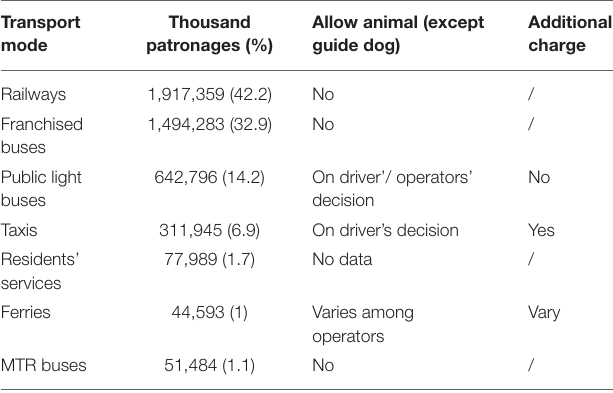
TABLE 1 | Public Transport Patronage in 2019 and animal-friendly policy by Mode. Transport